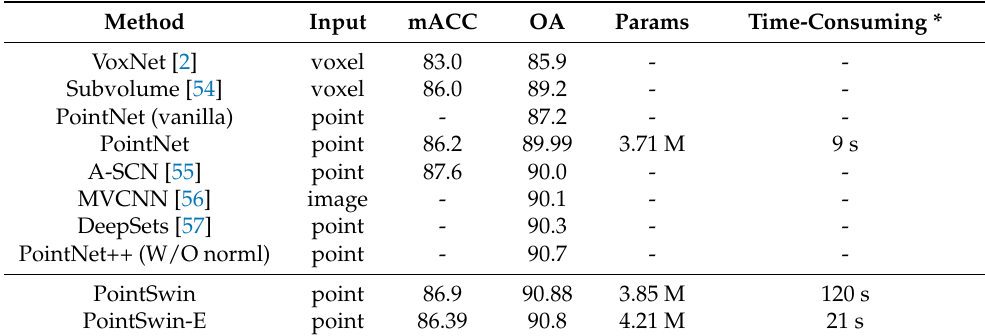
Table 1. Results of ModelNet40 shape